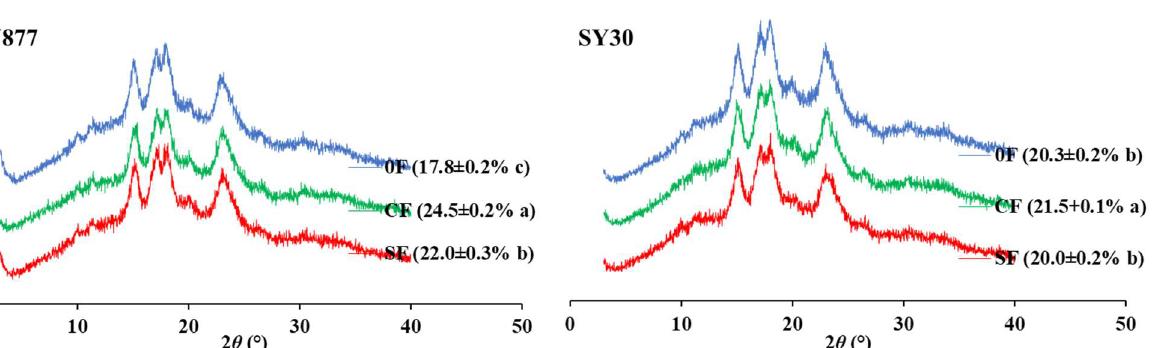
Figure 3. Effects of the fertilization mode on isoamylase-debranched amylopectin chain length dis- tribution of normal maize . The data in brackets are the average chain length. Mean values within the same hybrid followed by different letters are significantly different at p < 0.05. JY877, Jiangyu877; SY30, Suyu30; 0F, zero fertilization; CF, common fertilization; SF, slow-release fertilization.